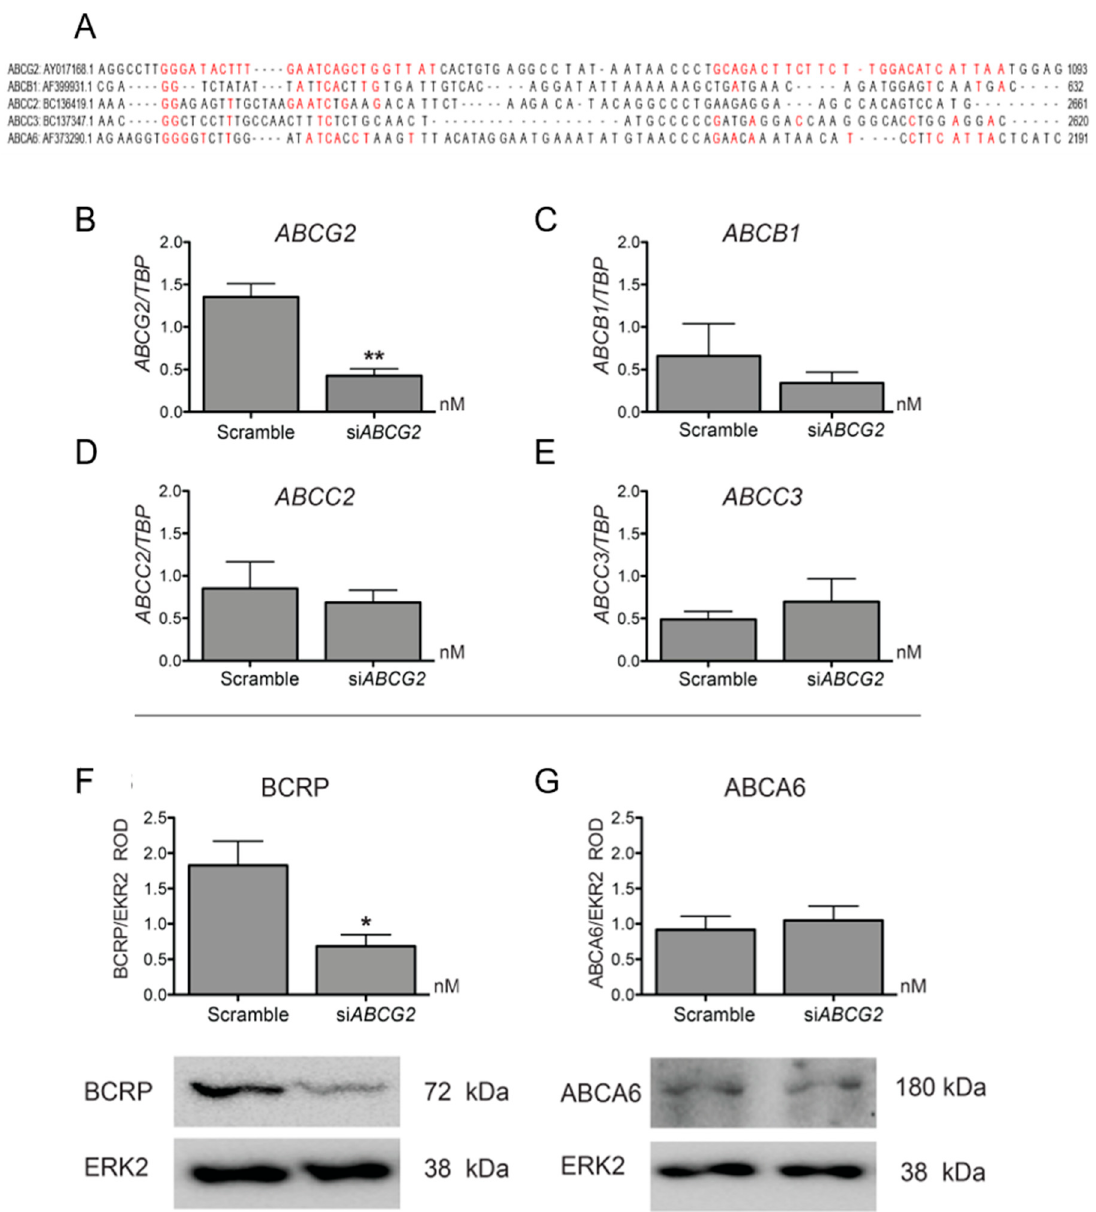
Figure 2. Validation of siRNA mediated knock down of BCRP in HTR8 / Svneo cell line. ( A ) Target region of ABCG2 siRNA sequences (1 & 2 shown in red) aligned with the mRNA of ABCG2, ABCB1, ABCC2, ABCC3 and ABCA6 using Multiple Sequence Analysis by Clustal Omega (EMBL-EBI). ( B – E ) mRNA analysis post siRNA transfection. TBP was used as reference gene for data normalization. ABCG2 mRNA was significantly downregulated while that of the other transporter genes; ABCB1 , ABCC2 and ABCC3 remained una ff ected in siRNA transfected cells compared to the scrambled control ones. ( F – G ) Western blot analysis of cells post siRNA transfection. BCRP protein was downregulated 48 h post si ABCG2 transfection while ABCA6 protein remain una ff ected illustrating the specificity of siRNA for BCRP. Graphs show densitometric analysis of BCRP expression ( F ), and ABCA6 ( G ) normalized to total ERK2. Statistical di ff erences were tested by unpaired t test, * p < 0.05, ** p < 0.01 mRNA n = 4; Protein n = 3 per group.